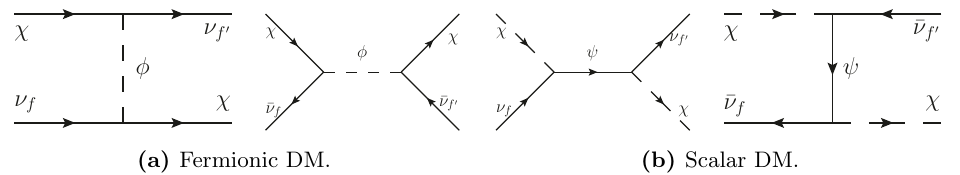
(cid:23) and (cid:31) (cid:22) (cid:23) scattering for the fermionic DM case (a) (cid:0) (cid:0)